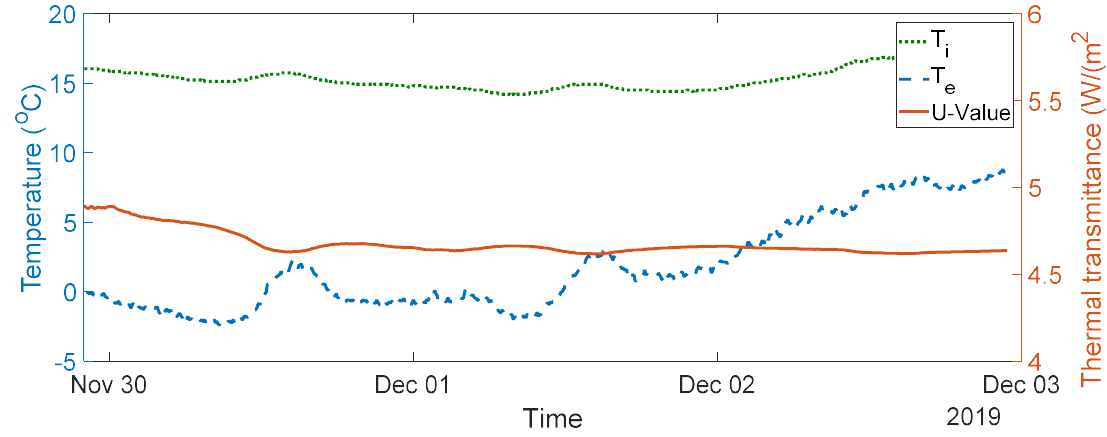
Figure 8. Thermal transmittance measurement data between Day 3 and Day 5.